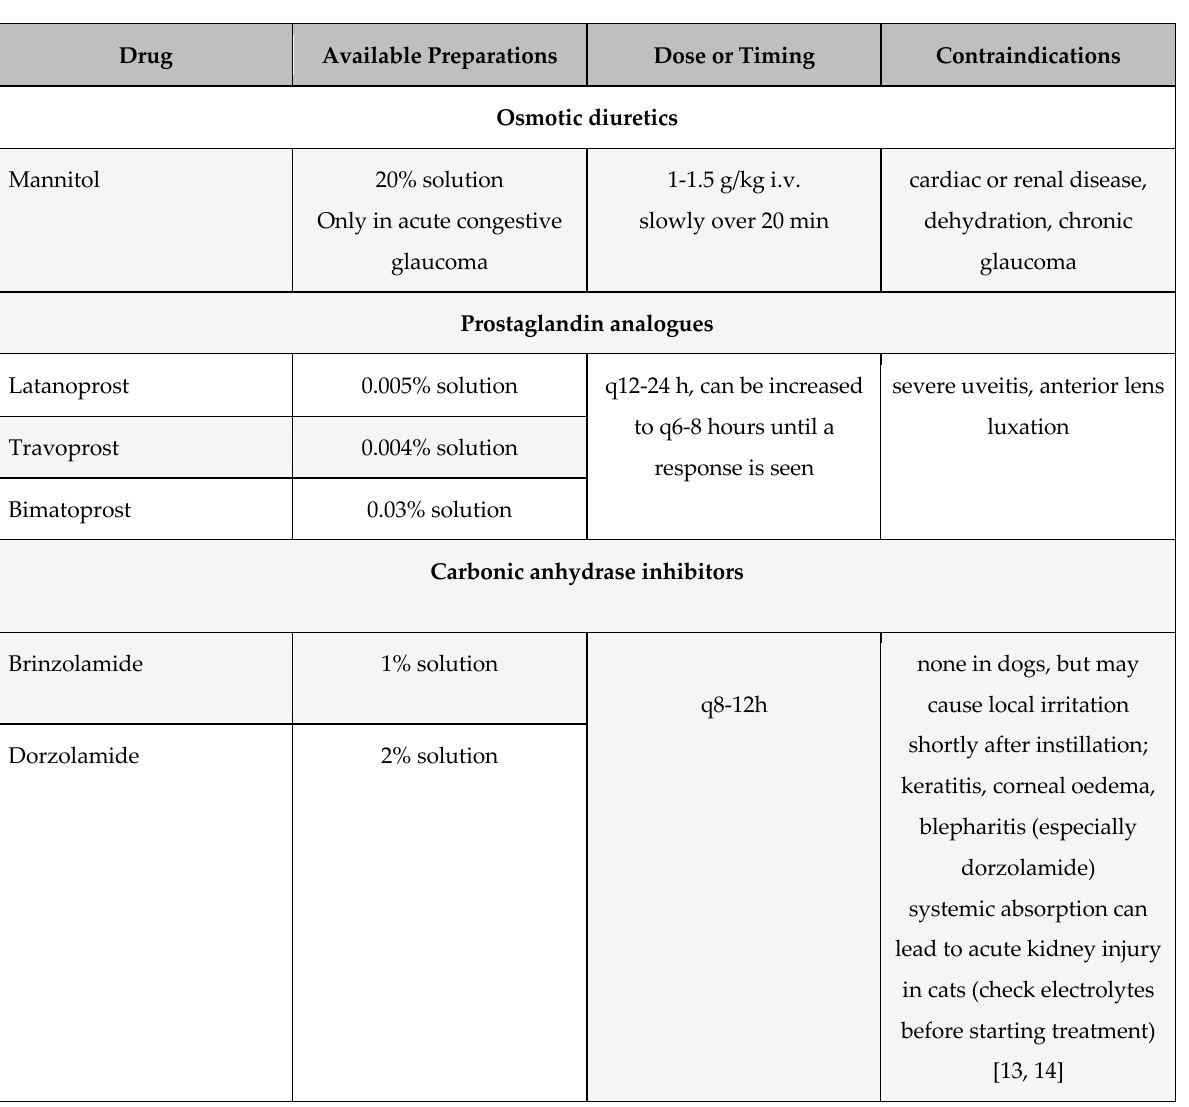
Table 2. Most commonly used hypotensive drugs for glaucoma in dogs and cats Source: Adapted after